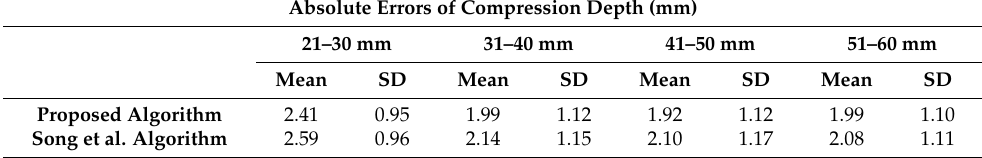
Table 1. Absolute errors at the four compression